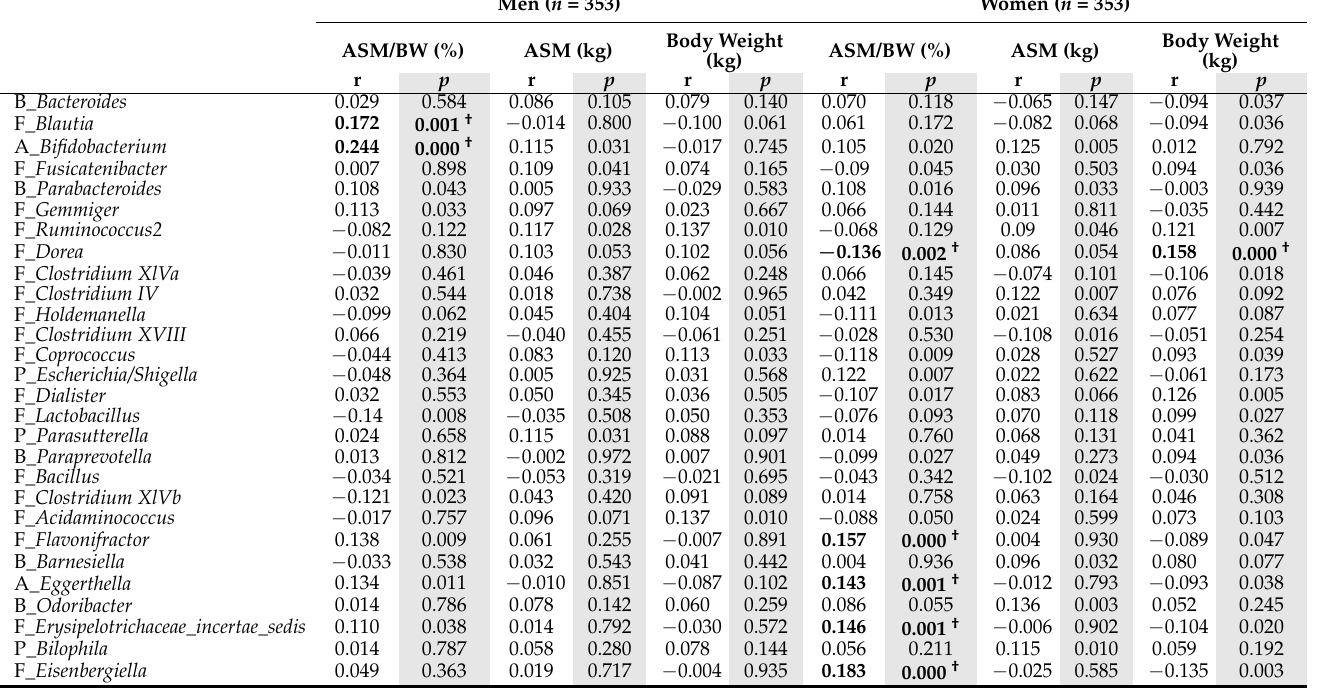
Table 3. Spearman’s correlation between gut microbiota and body composition.